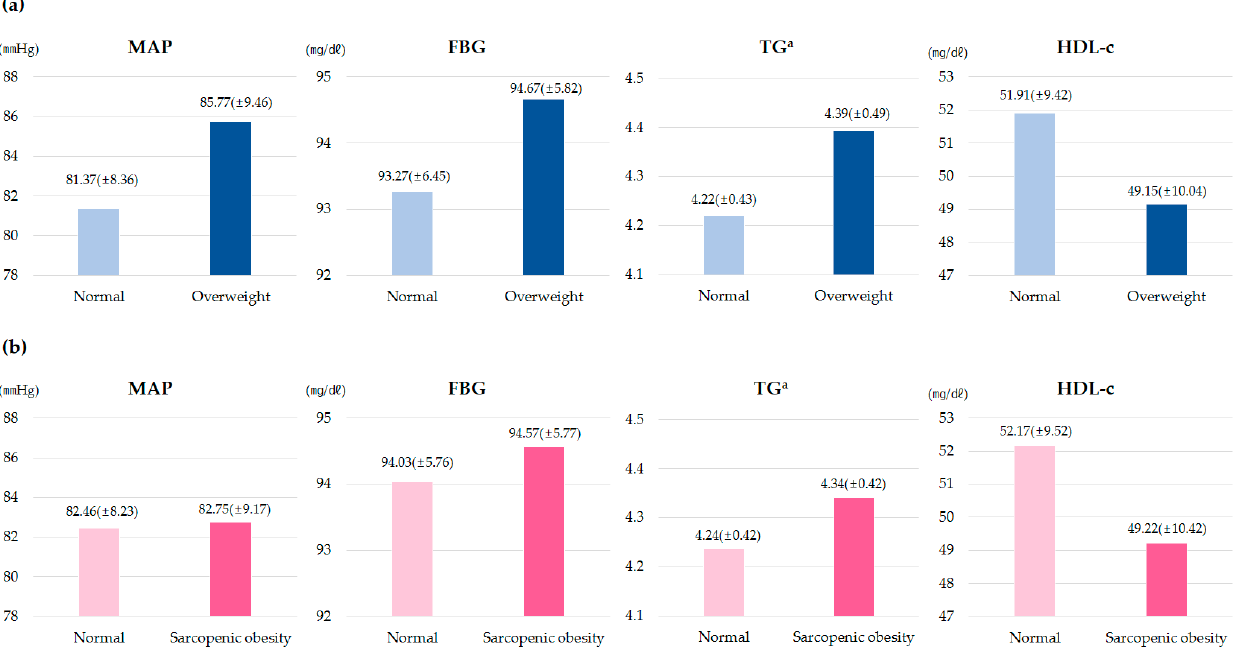
Figure 1. Distribution of metabolic risk factors among study subjects according to childhood obesity. MAP, mean arterial pressure; FBG, fasting blood glucose; TG, triglyceride; HDL-C, high-density lipoprotein cholesterol; ( a ) Subjects were classified as normal or overweight with the 85th percentile as the cut-off point; ( b ) sarcopenic obesity was defined as 1.25 for boys and 1.1 for girls. a Log transformation was performed because it was not normally distributed. Table 3. Mean difference in the metabolic syndrome index in adolescence according to childhood overweight and sarcopenic